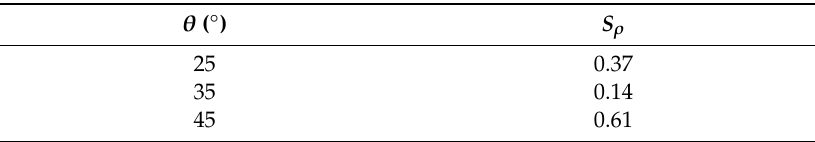
Table 5. S ρ for di ff erent values of θ Table 5. S ρ for different values of θ .